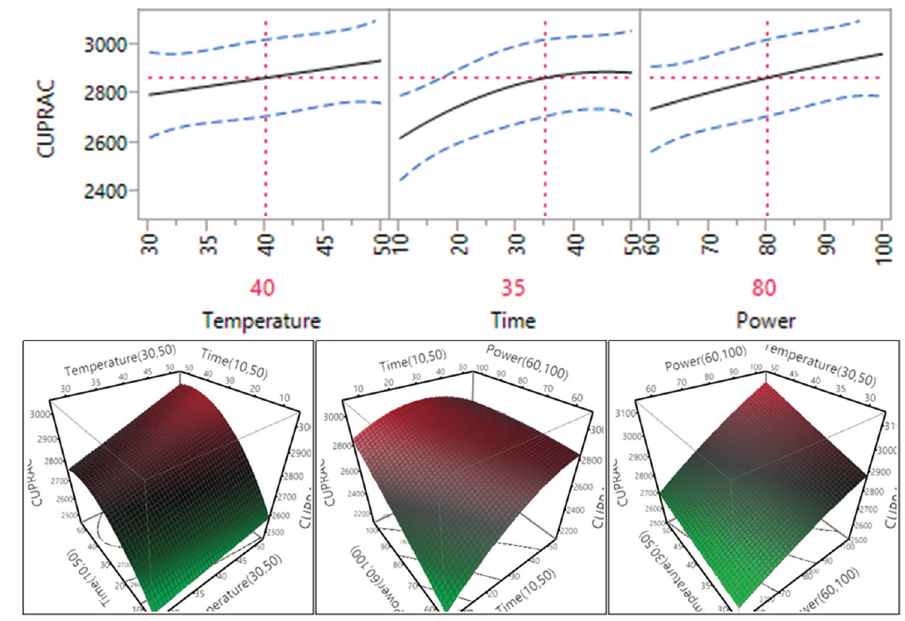
Figure 9. Impact of temperature (60–90 °C), time (10–30 min) and power (60%–100%) on CUPRAC.